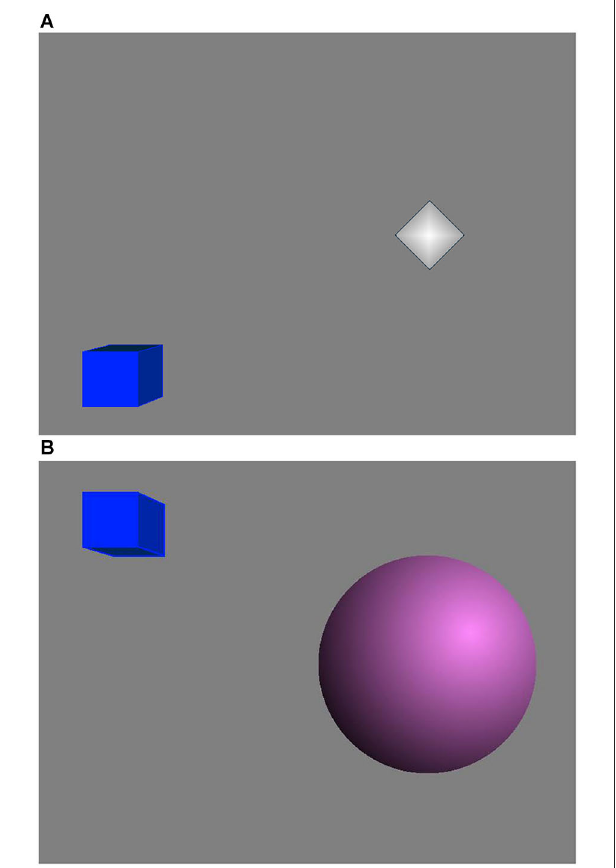
FIGURE 2 | Neurofeedback display . (A) When Goal 1 was not achieved. (B) When both Goal 1 and Goal 2 were